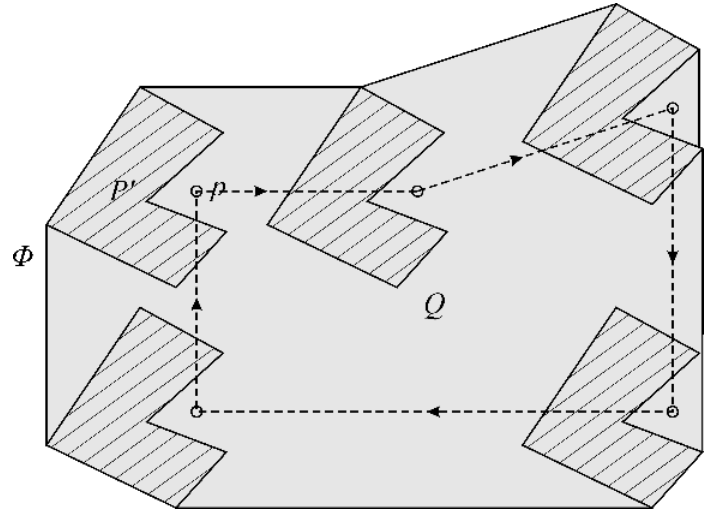
Figure 4. Schematic diagram of the Minkowski addition of polygons.